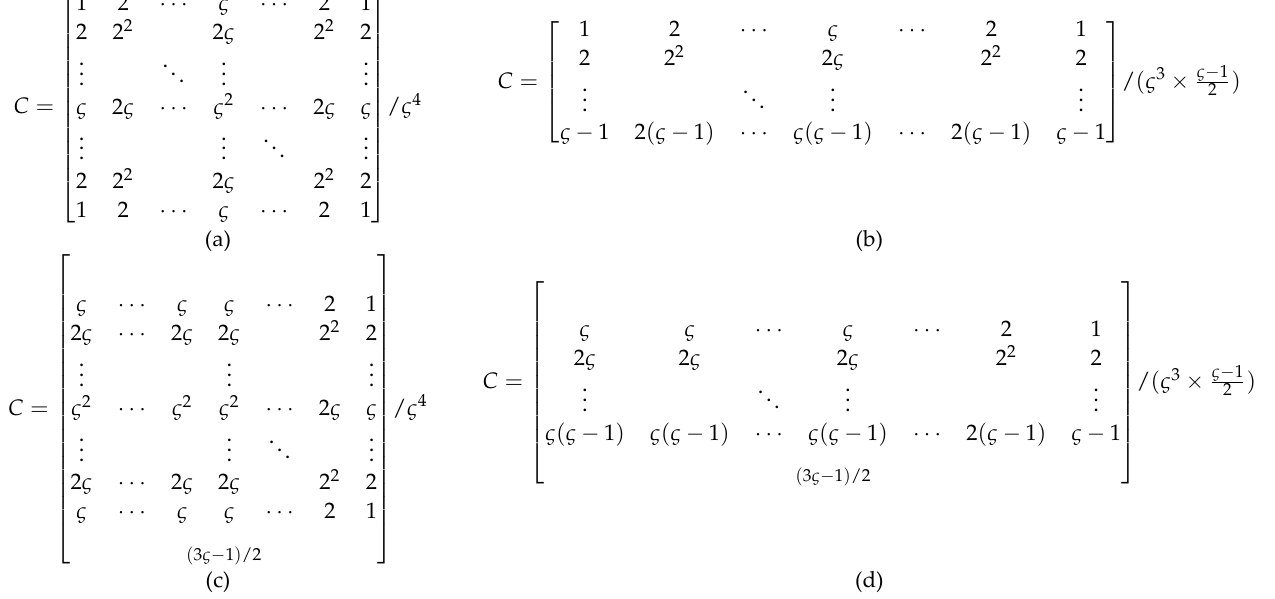
Figure 3. 3‑D subgridding interface and weighted magnetic field, where ( a ) E x is at the middle of the E is at the middle of Figure 3. 3-D subgridding interface and weighted magnetic field, where ( a ) x interface, ( b ) E x is parallel to the boundary of the interface, ( c ) E x is perpendicular to the boundary E is parallel to the boundary of the interface, ( c ) E is perpendicular to the the interface, ( b ) x x of the interface, and ( d ) E x is perpendicular to one boundary of the interface and parallel to another E is perpendicular to one boundary of the interface and parallel boundary of the interface, and ( d ) x boundary of the to another boundary of the interface. C in Equation (19) has different four expressions which cor- The coefficient matrix k respond to four different situations in Figure 3.